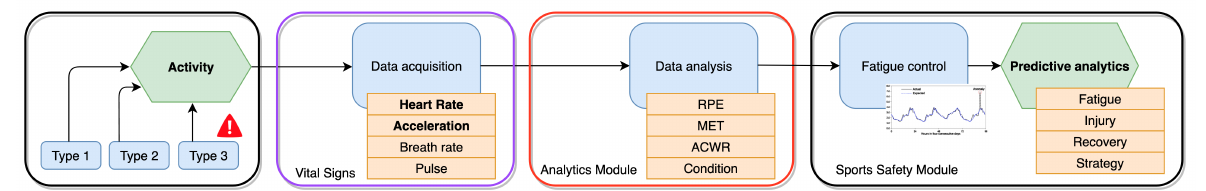
Figure 1. Next-Generation Sports Safety